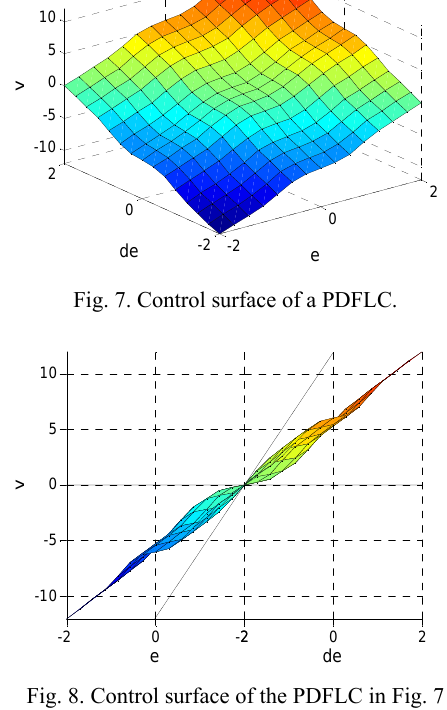
Fig. 8. Control surface of the PDFLC in Fig. 7 observed from azimuth o 45 and elevation o 0